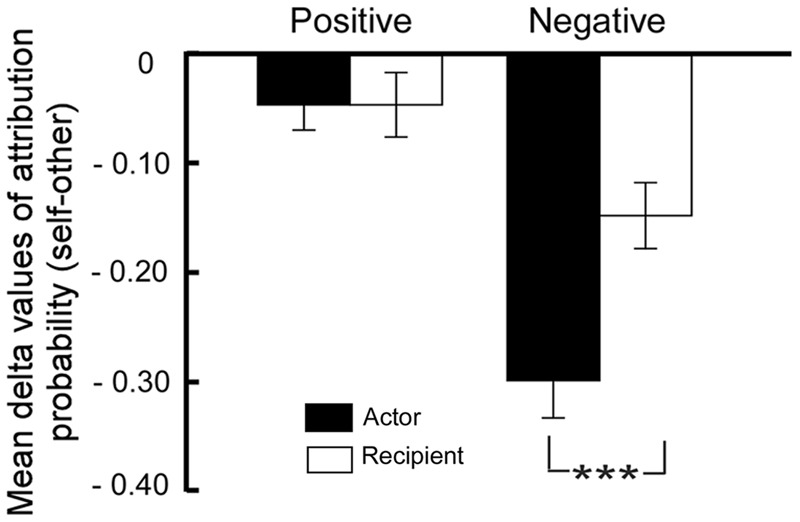
Mean delta values (self–other) when the self was an actor or a recipient in positive and in negative interpersonal events (∗∗∗p < 0.001; error bars indicate standard error of the mean).